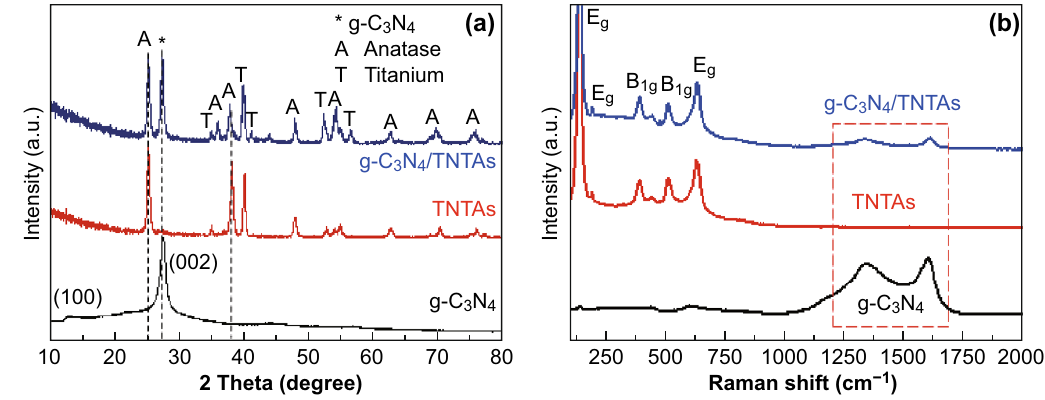
Fig. 2 a XRD and b Raman spectra of g-C 3 N 4 , TNTAs, and g-C 3 N 4